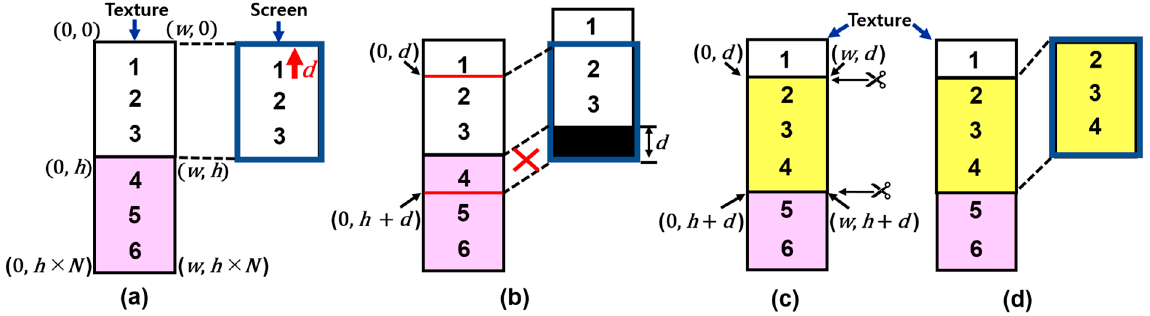
Figure 6. Cropping and mapping operations: ( a ) scrolling; ( b ) after scrolling; ( c ) cropping; ( d ) mapping.